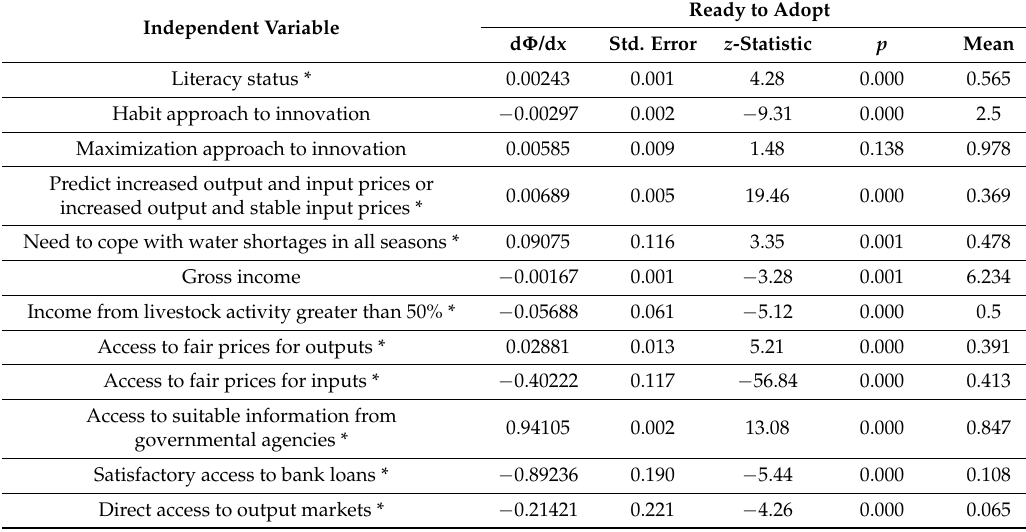
Table 7. Impacts on adoption probability. * indicates dummy